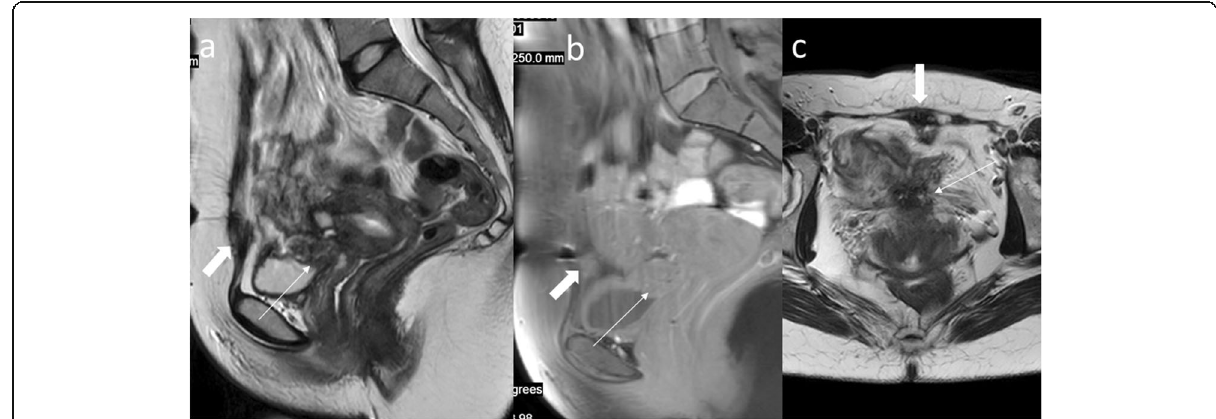
Fig. 11 Pelvic MRI consulted for Sports Medicine Centre, Warsaw (images published with permission). FSE/T2WI in the sagittal ( a ) and axial ( c ) planes, FSE, T1 fat-saturated image, and the sagittal plane ( b ). Endometriotic implants on the way of C-section: in the bladder wall (thin arrows) and in the abdominal wall (thick arrows). The lesions are mostly T2-hypointense and T1-isointense, with very tiny foci of hyperintensity